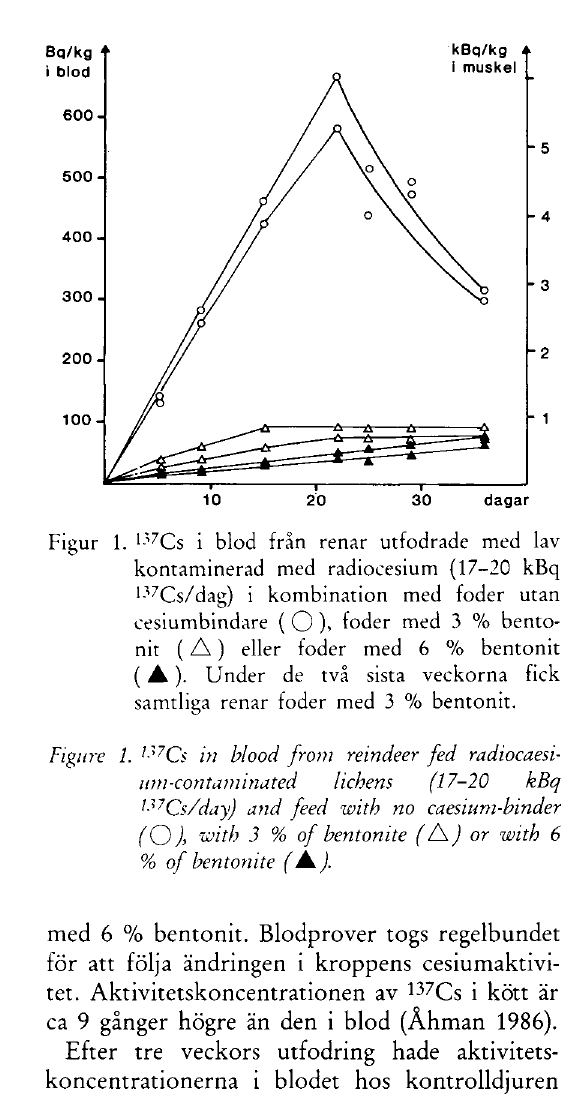
Figur 1. 137 Cs i blod från renar utfodrade med lav kontaminerad med radiocesium (17-20 kBq 137 Cs/dag) i kombination med foder utan